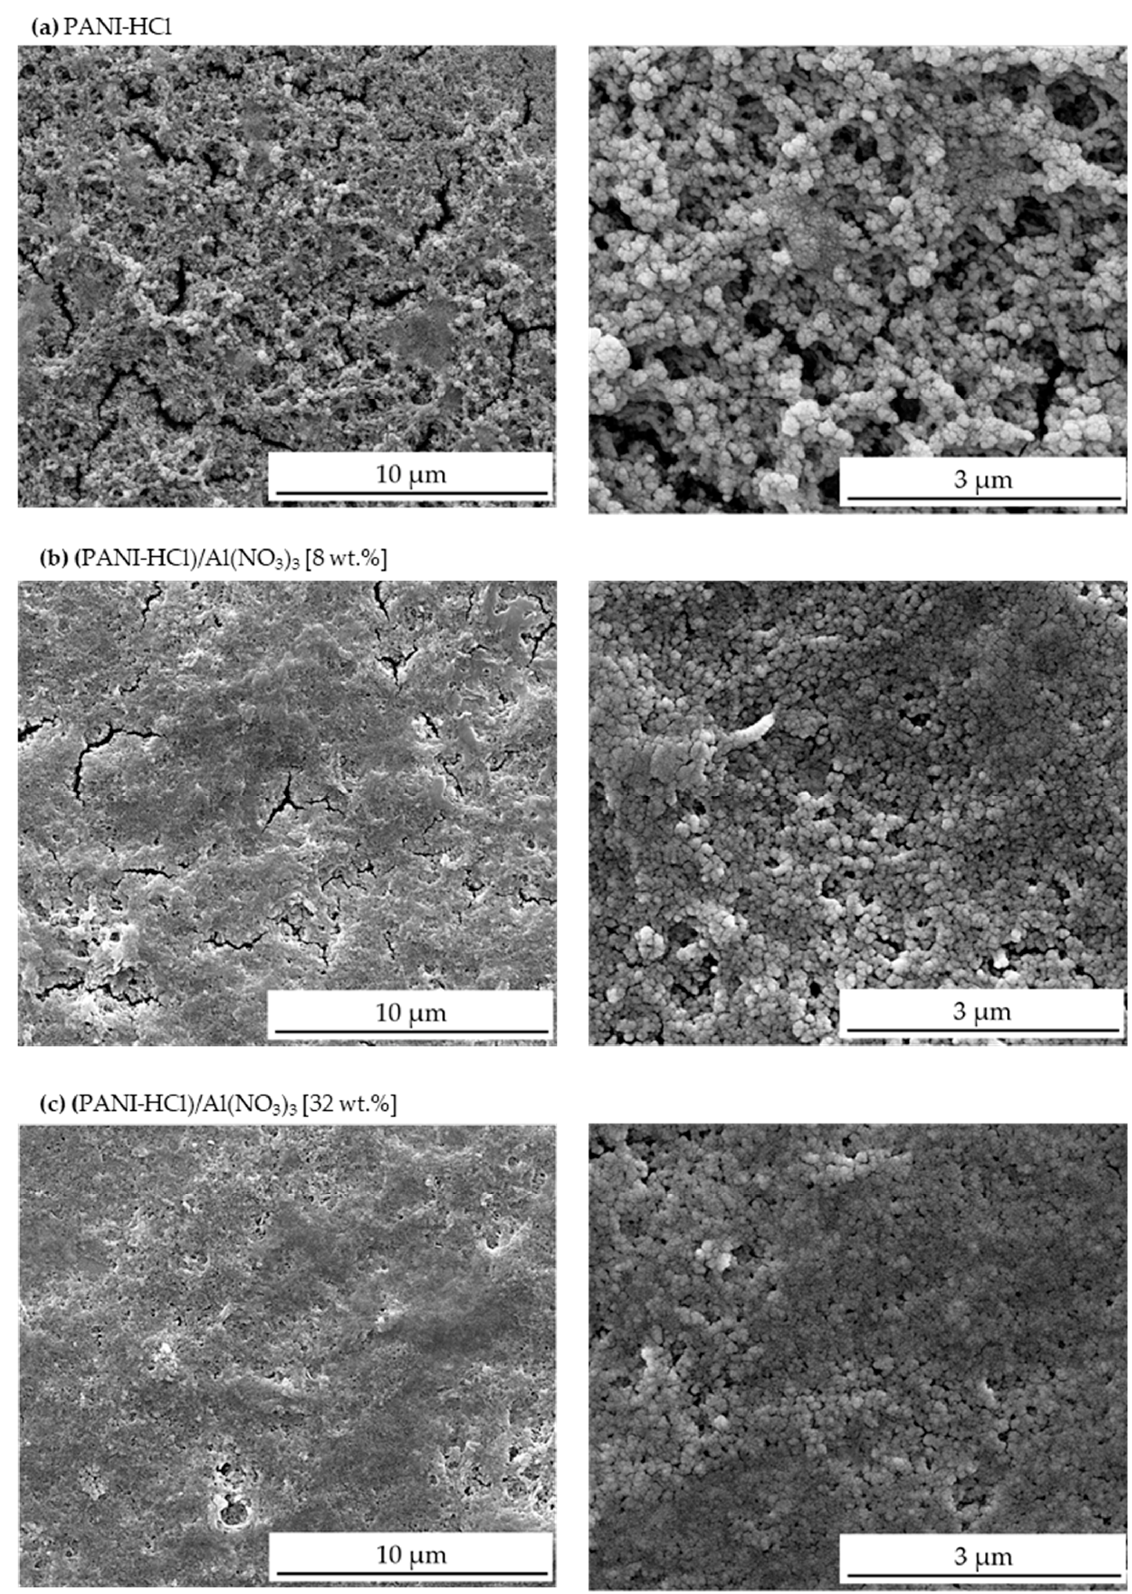
Figure 3. SEM micrographs from (PANI-HCl)/Al(NO 3 ) 3 complex composite films with Al(NO 3 ) 3 concentration (0, 8, and 32 wt.%).